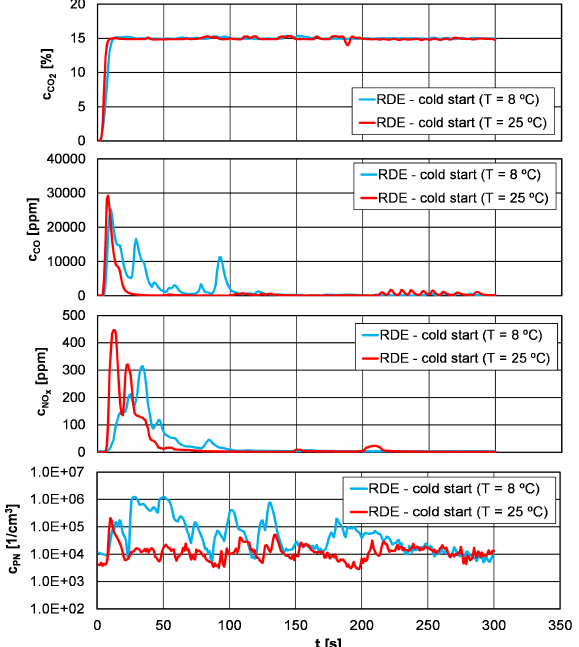
Figure 6: The change of exhaust gases concentration during the initial 300 s from the cold start for different values of ambient temperature for: carbon dioxide, carbon monoxide, nitrogen oxides, and particles number